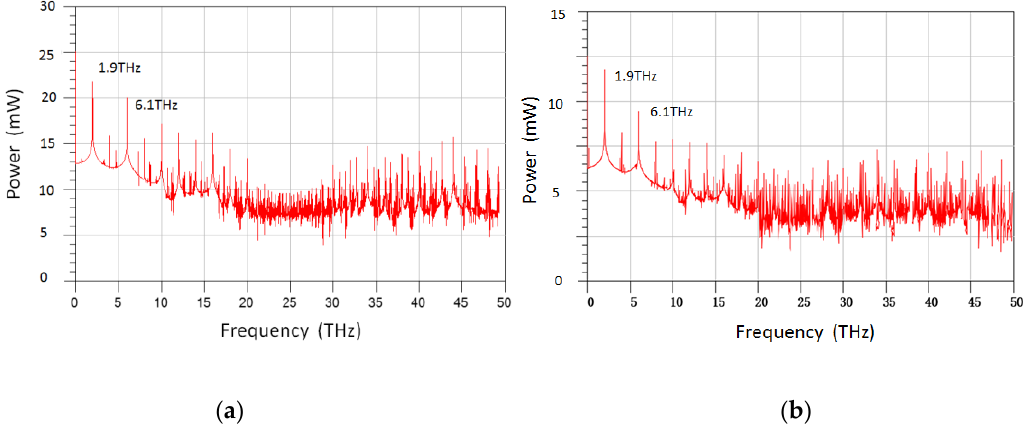
Figure 5. Power spectrum of oscillator: ( a ) Device dimensions are L = 2 µm and W = 10 µm. ( b ) Device dimensions are L = 1 µm and W = 10 µm.